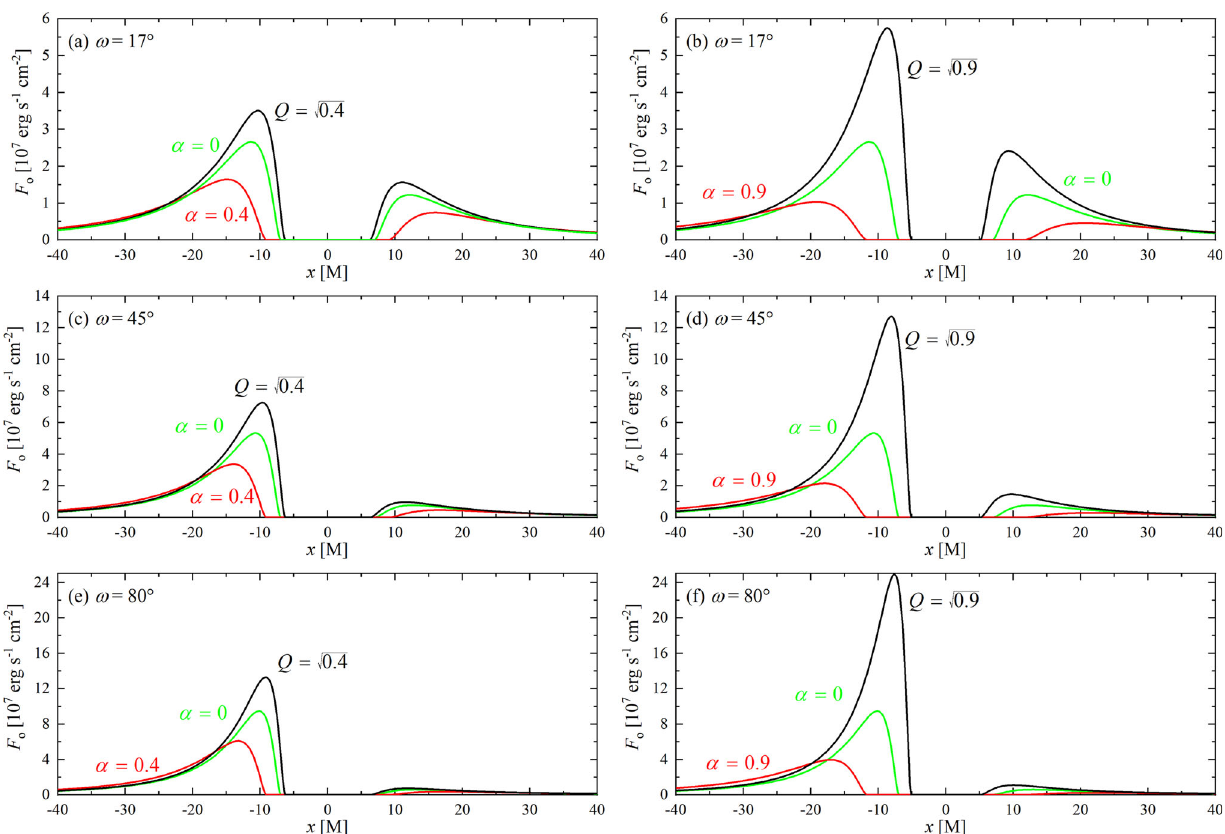
Fig. 11 The distribution of observed flux along the x -axis of the observation screen for the three types of BHs. The black, green, and red lines correspond to the RN BH, Schwarzschild BH, and Schwarzschild-MOG BH,